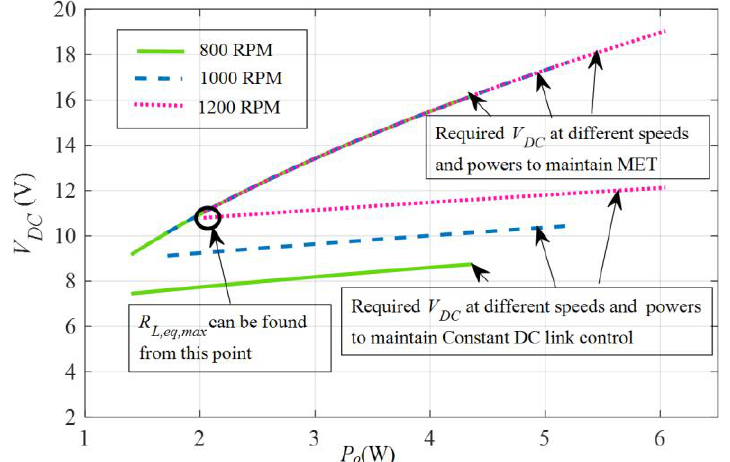
Figure 6. Voltage requirements for MET and constant DC‑link voltage control with respect to power demand and speed. Parameters are selected based on values in Table 1.